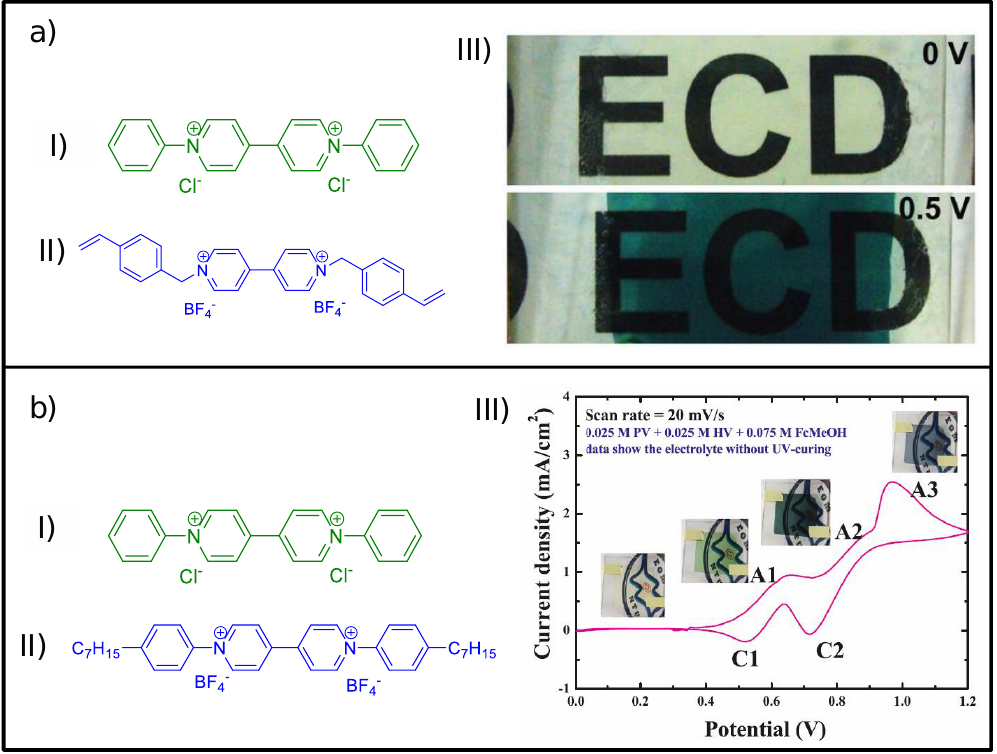
Figure 11. ( a ) ECD based on ( I ) phenyl viologen dichloride (PhVio Cl 2 ) and ( II ) vinyl benzyl viologen tetrafluoroborate (BnVio (BF 4 ) 2 ) and ( III ) photograph of the corresponding ECD at bleached (0 V) and colored (−0.50 V) state. ( b ) ECD based on ( I ) PhVio Cl 2 and ( I I) heptyl viologen tetrafluoroborate (HVio (BF 4 ) 2 ) and ( III ) cyclic voltammogram of the corresponding uncured two-electrode ECD at a scan rate of 20 mV/s. (aIII) Reprinted with permission from [64], copyright (2016) American Chemical Society, and (bIII) reprinted from [122], copyright (2017), with permission from Elsevier.